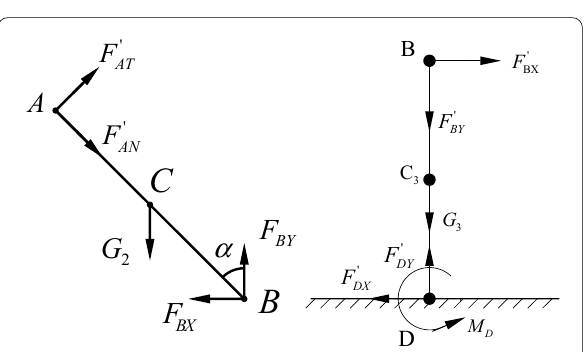
Figure 5 Forces of the cantilever and the